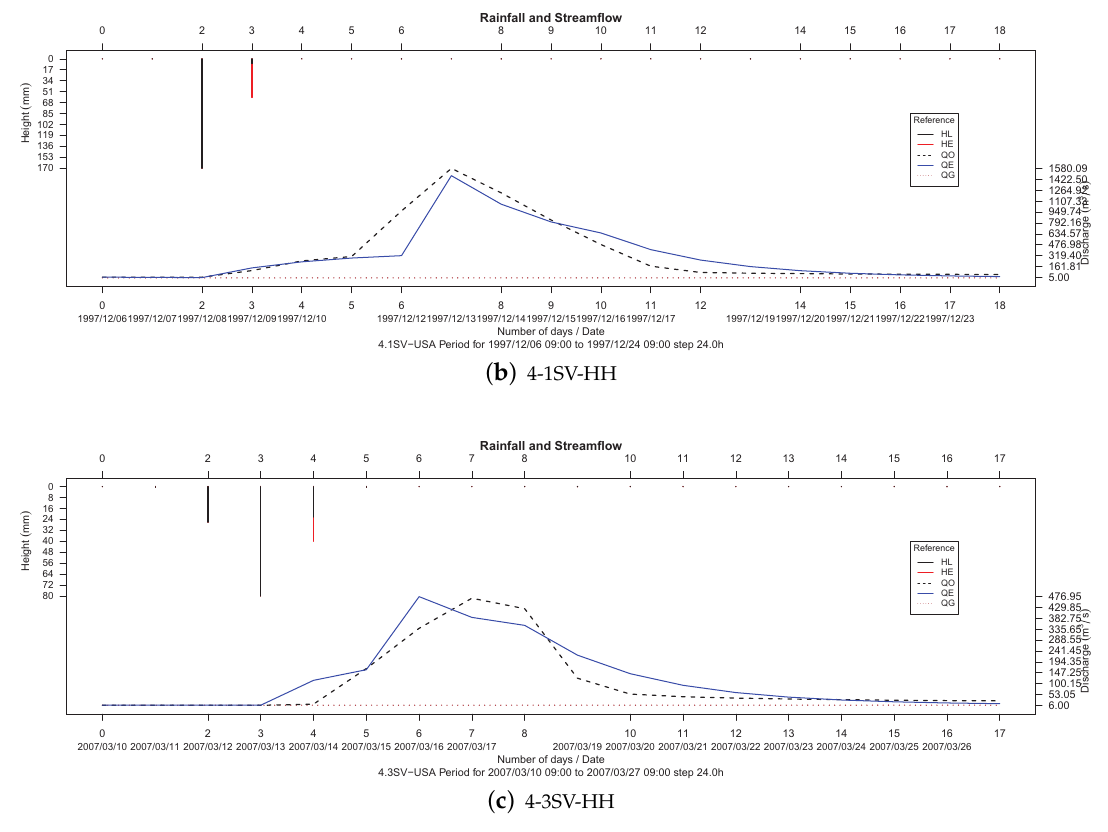
Figure 15. Hyetograph and Hydrograph from calibration 4-2SC-HH and idem for validation 4-1SV-HH and 4-3SV-HH data series.